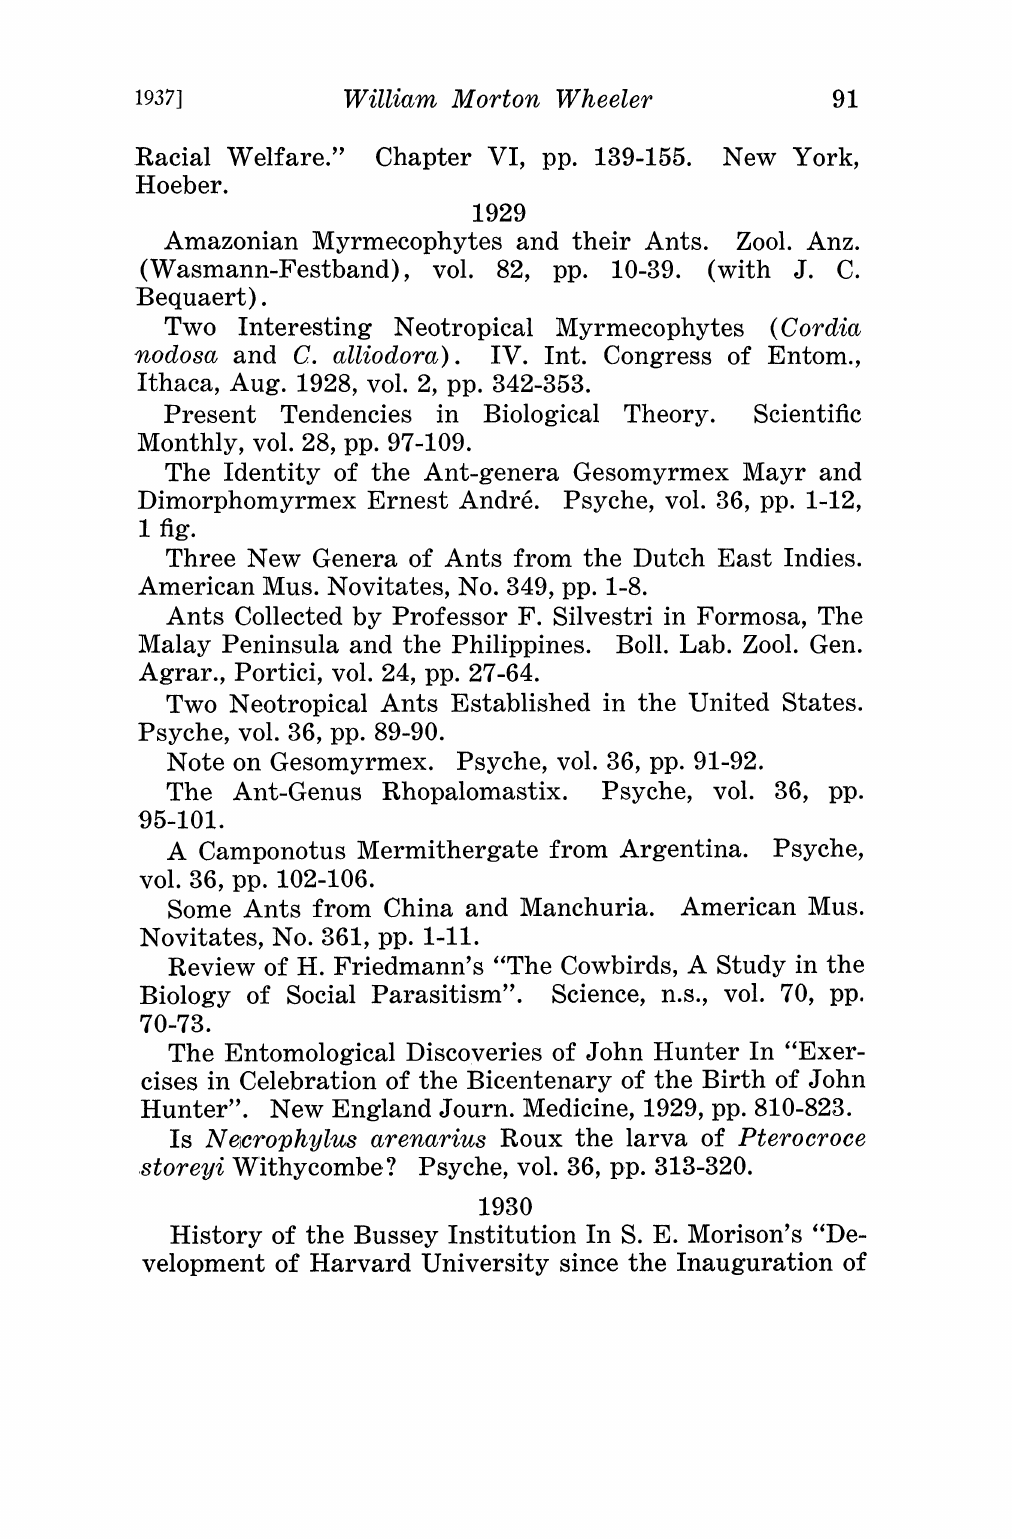
Three New Genera of Ants from the Dutch East Indies. American Mus. Novitates, No. 349, pp.